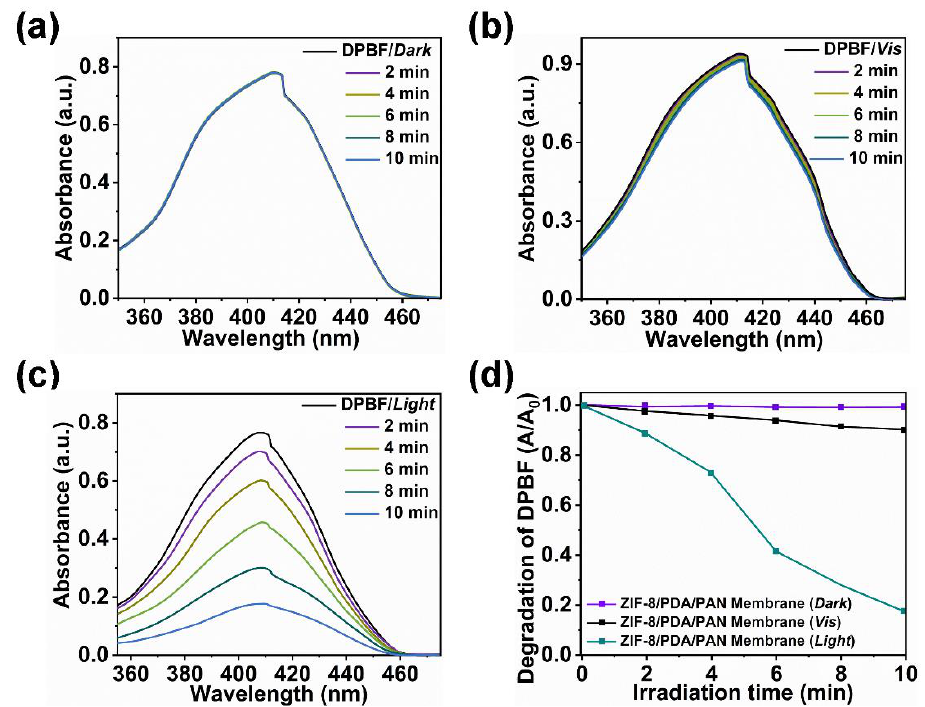
Figure 6. UV – vis spectrum of the ZIF – 8/PDA/PAN composite membrane in DPBF solution under ( a ) dark, ( b ) visible light, and ( c ) simulated sunlight conditions for 2 min, 4 min, 6 min, 8 min, and 10 min, respectively; ( d ) normalized degradation curve of the DPBF solution absorbance change at 410 nm under different light conditions.